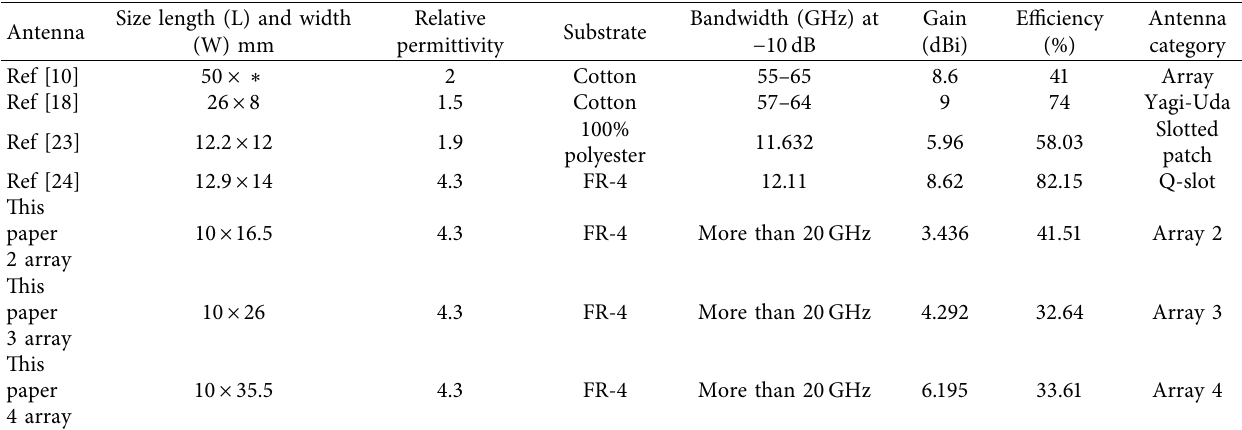
Figure 35: 60GHz on-body comparison of radiation patterns between Array 2, 3, and 4. (a) E-plane. (b) H-plane. Table 11: A comparison of this paper’s research with that of other